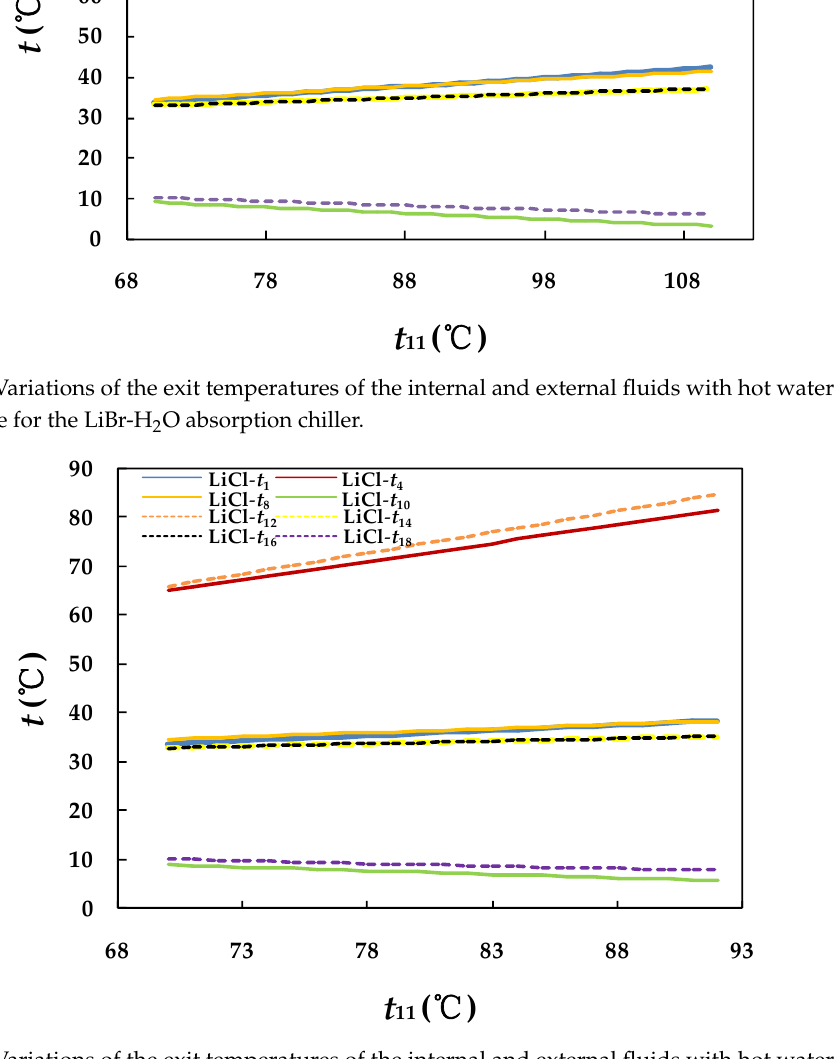
Figure 15. Variations of the exit temperatures of the internal and external fluids with hot water inlet temperature for the LiCl-H 2 O absorption chiller.